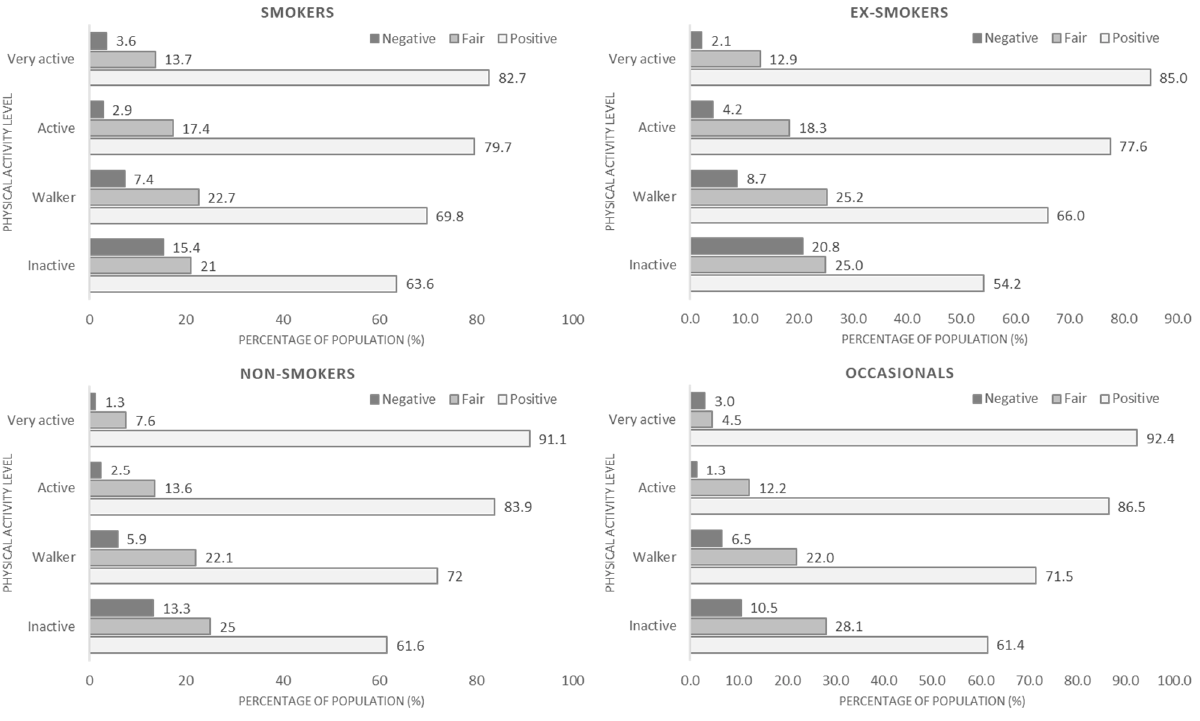
Figure A4. Self-perceived health of the Spanish population, according to their level of physical activity for each smoking status.